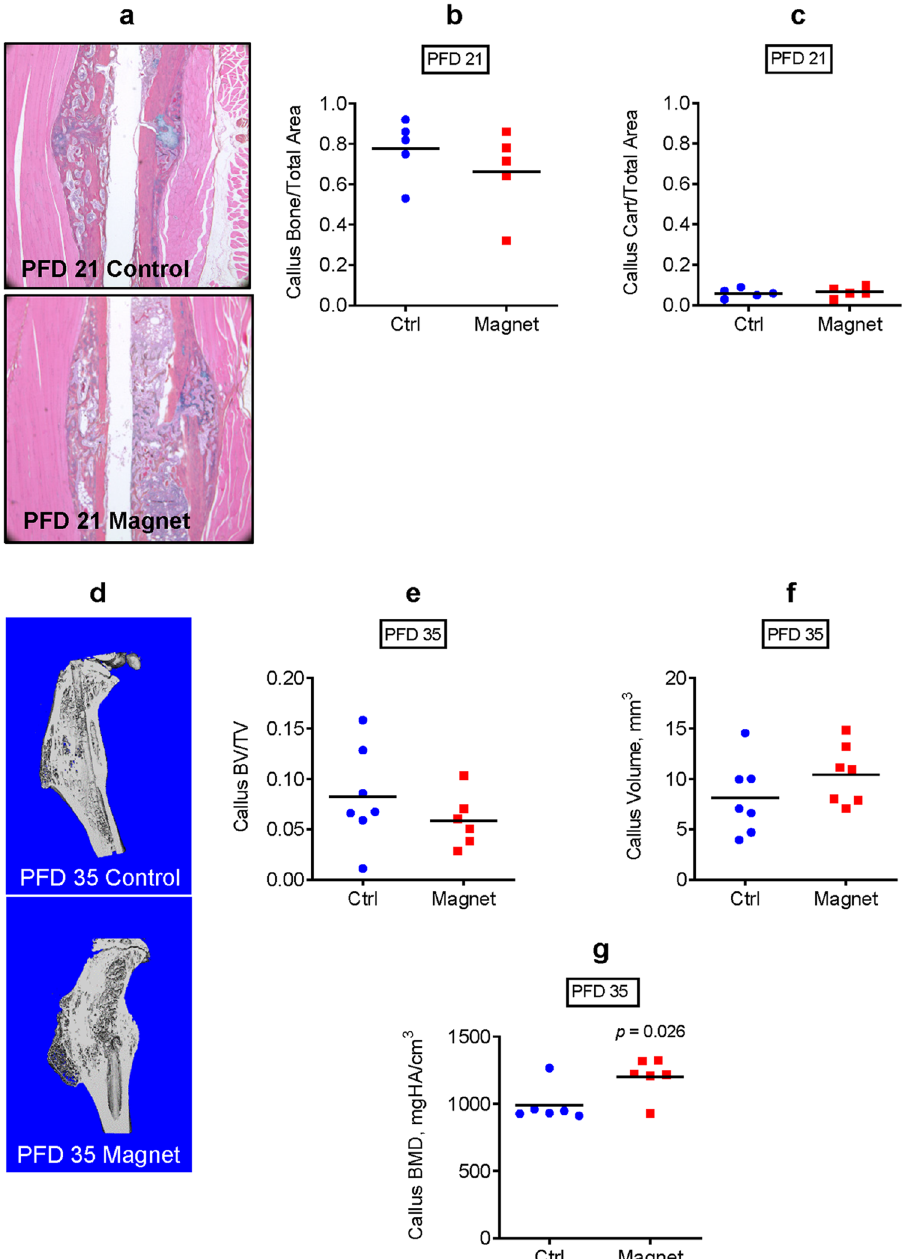
Figure 5. Electromagnetic field stimulation increases callus mineralization during tibial fracture repair in mice. ( a ) Histology of tibial fracture callus on post-fracture day (PFD) 21 and histomorphometric analyses of ( b ) callus bone vs total area and ( c ) callus cartilage vs total area; ( d ) Sagittal sections of 3D-reconstructed images from micro-CT analysis on PFD 35; ( e ) Total callus volume measured with micro-CT; ( f ) Bony callus fraction (BV/TV) measured with micro-CT; ( g ) Callus bone mineral density (BMD) measured with micro-CT. Plots show actual data points and calculated means. P value was determined via the t